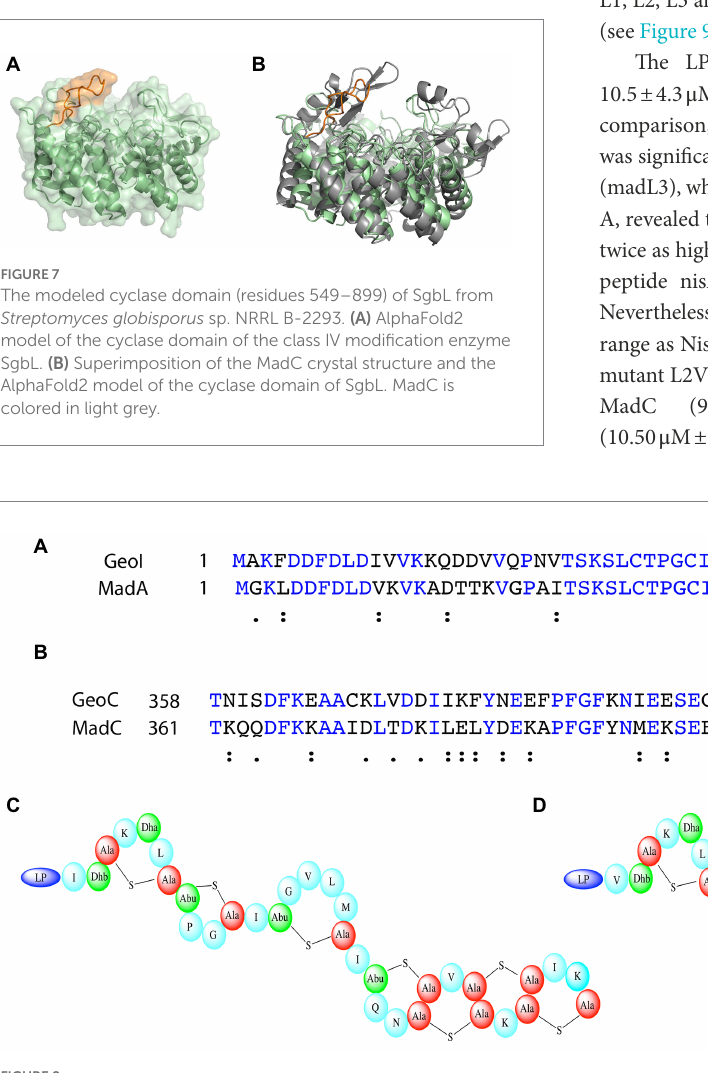
FIGURE 8 Comparison of maddinglicin and geobacillin-I and the corresponding cyclases. (A) Sequence alignment of MadA and GeoI via Clustal Omega. Blue colored amino acids indicate identical amino acids for this 2 sequence alignment, “:” indicates very similar amino acids; “.” indicates similar amino acids (B) Sequence alignment of MadC and GeoC via Clustal Omega. Only the part including the β -sheet domain of MadC is displayed for comparison. Blue colored amino acids indicate identical amino acids for this 2 sequence alignment, “:” indicates very similar amino acids; “.” indicates similar amino acids (C) Proposed structure of MadA. (D) Solved structure of GeoI (Garg et al., 2012).